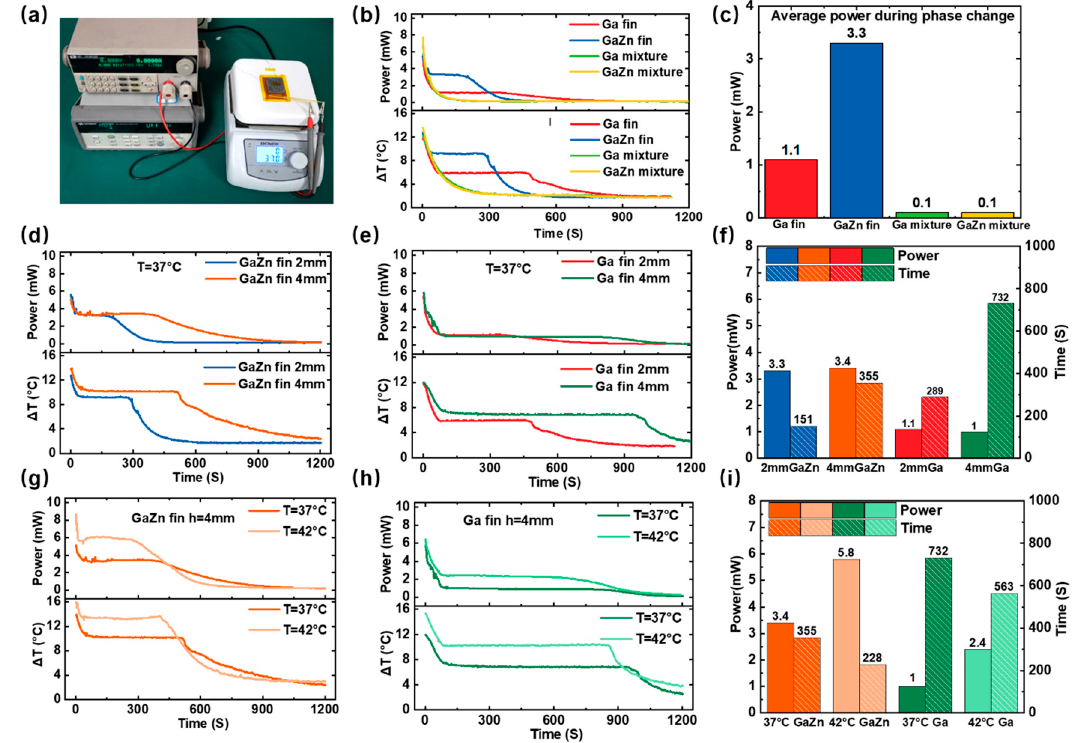
Figure 3. The impacts of LM-finned heat sink on the performance of the WTEG: ( a ) the test platform; ( b ) output power and the temperature ∆ T of the LM-WTEG for four types of LM fins with the height of 2 mm and ( c ) the corresponding to average outpower during phase change; the impacts of the fin height on the LM-WTEG performance for ( d ) GaZn fin and ( e ) Ga fin, and ( f ) the output power; the impacts of the heat source for the cases of ( g ) GaZn fin and ( h ) Ga fin, and ( i ) the output power . When the fin height of 2 mm increases to 4 mm, the phase-change duration would be extended to enhance the performance of the LM-WTEG, as shown in Figure 3d–f. For the GaZn fin with a height of 4 mm, the phase change time is 355 s, which increases 135% compared with that of 2 mm (151 s). Similar results are also found for the Ga-based case, such as the output power of 1.1 mW with a duration time of 270 s for the height of 2 mm, and 1 mW and 732 s for the fin height of 4 mm, respectively. It is interesting to find that the output powers are nearly equal for the cases with the fin heights of 2 mm and 4 mm during the phase change due to the relatively constant temperature difference of ∆ T . The impacts of heat sources on LM-WTEG are studied by changing the surface tem- perature of the hot plate from 37 °C to 42 °C. Figure 3g–i show the output power, temper- ature difference of ∆ T , and the duration time of the phase change for the Ga/GaZn finned heat sink with the height of 4 mm. When the temperature of the heat source is 42 °C, the output power increases to 5.8 mW (483 μ W/cm 2 ), which is 1.8 times that of 37 °C. Similarly, the output power increases from 1 mW at 37 °C to 2.4 mW at 42 °C with an increase of 140%. The main reason is that the temperature difference between the cold/hot sides of the LM-WTEG has increased from 7.5 °C to 13.5 °C. It could be concluded that increasing the temperature of the heat source can effectively increase Δ T, and thus largely improve the output power. It is also noteworthy that the duration time of the large output power would decrease when the heat absorption rate of PCM increases because of the heat source temperature increase. Figure 4 presents the impacts of wind speed on the LM-WTEG performance. A fan is placed on top of the LM-WTEG to stimulate the ambient airflow. For the GaZn-finned (h = 2 mm) WTEG, a wind speed of 0.4 m/s (corresponding to the walking speed) would enable a high output power of 4.08 mW (340 μ W/cm 2 ) with a duration time of 156 s (see